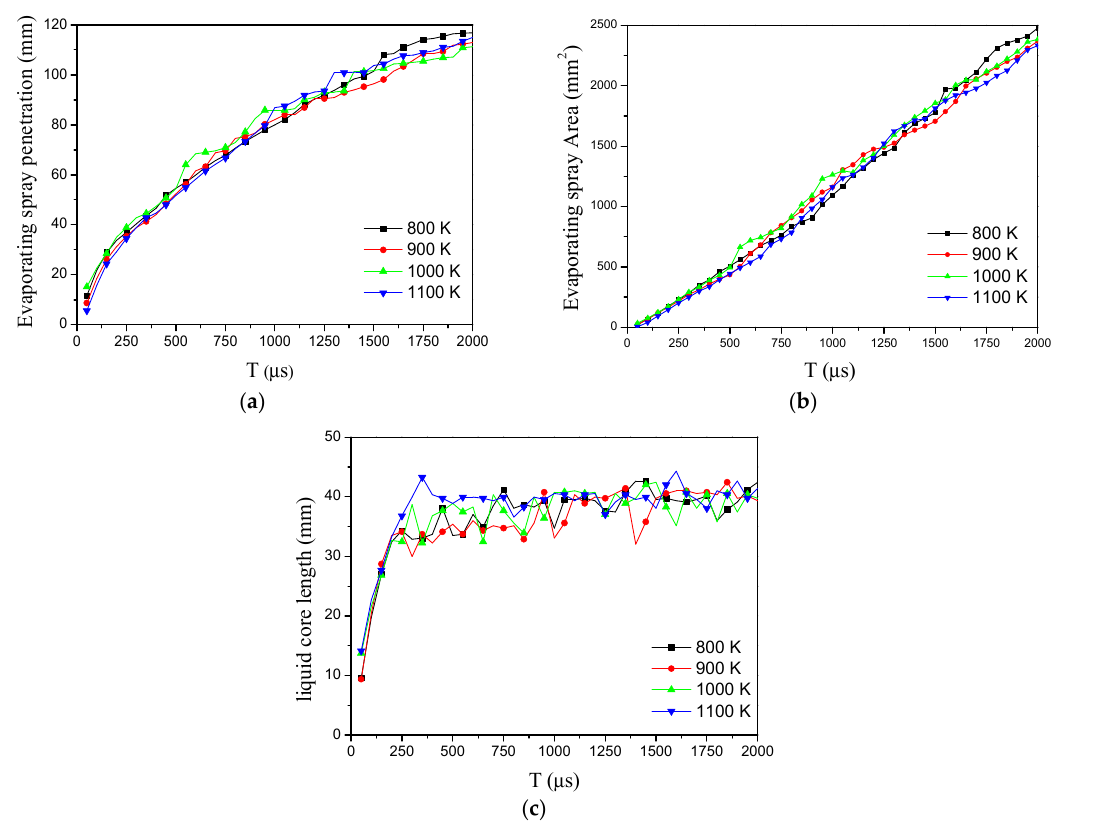
Figure 4. Spray characteristics in evaporating conditions: ( a ) Spray tip penetration; ( b ) Spray area; ( c ) Liquid core lengths.